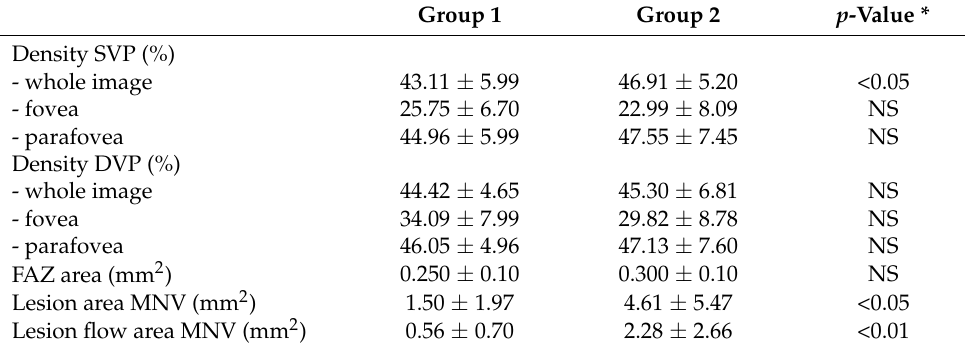
Table 2. Comparison of quantitative parameters of SVP, DVP and MNV in OCTA between